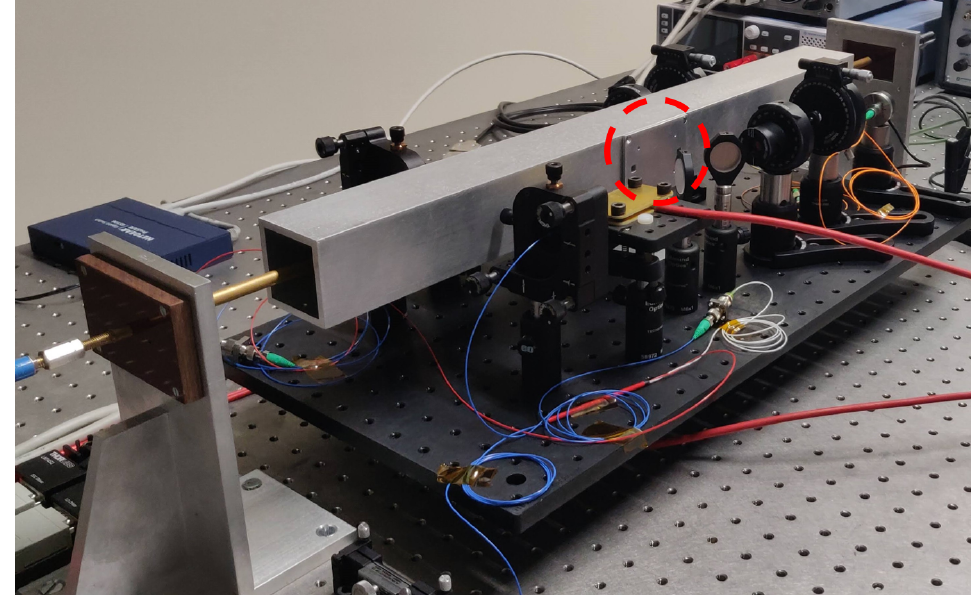
Figure 14. Proof-of-principle laboratory test bench. The red circle highlights the metallic holder used for the sensing